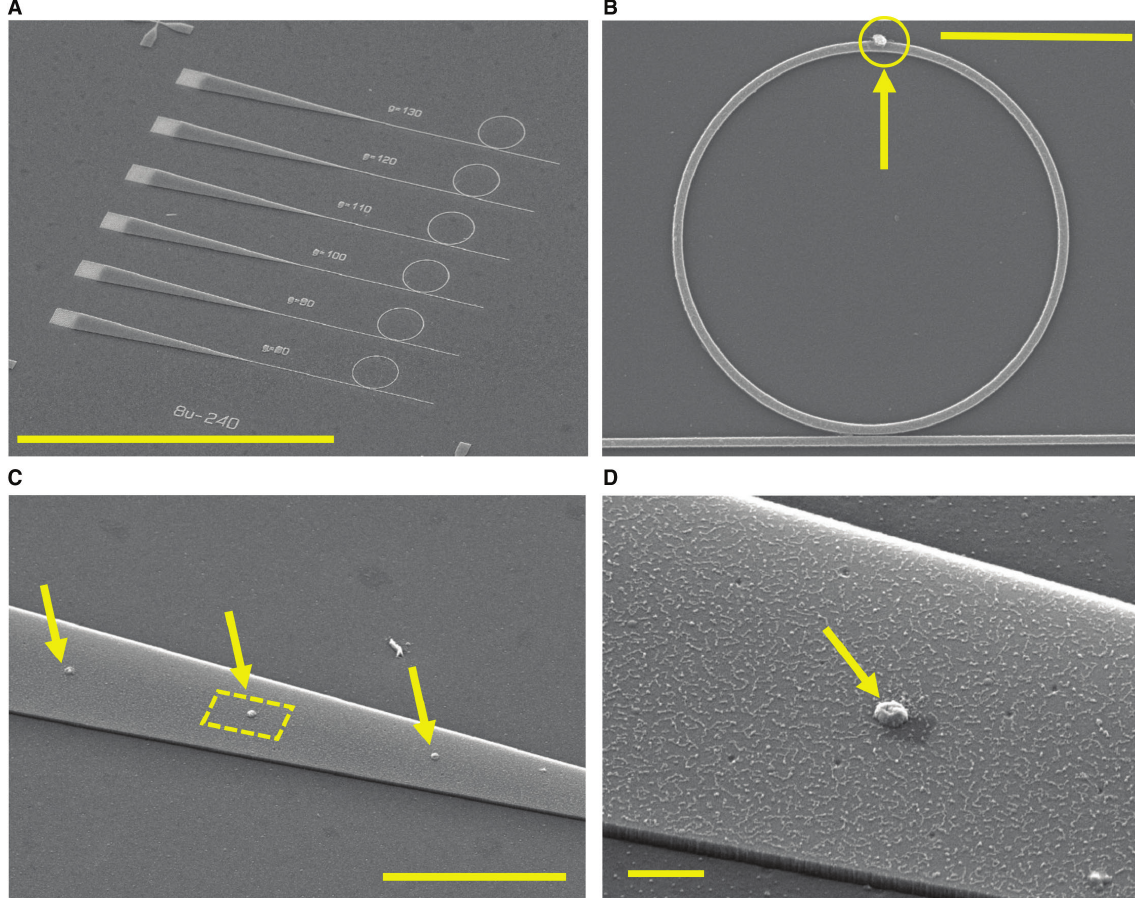
resonators on glass (scale bar = 100 μ m). The samples are Figure 6: (A) Bird-eye view scanning electron image of the integrated TiO 2 comprised of grating couplers, a tapered region connected to a 280 nm-wide waveguide in interaction with ring resonators. (B) Top view SEM image of a ring resonator equipped with a CoQDs aggregate (scale bar = 5 μ m). (C) SEM image of CdSe/CdS colloidal aggregates deposited at controlled locations marked by the yellow arrows (scale bar = 10 μ m). (D) SEM image of the aggregate surrounded by the square perimeter in (C). The aggregate is roughly semi-spherical with a radius around 200 nm (scale bar = 1 μ